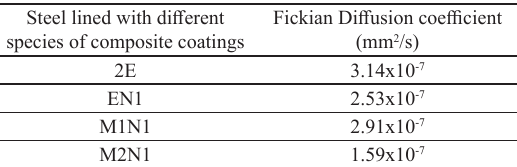
Table 3. Fickian Diffusion coefficient values of steel coated by epoxy and epoxy filled with micro/nano Al in citric acid solution.